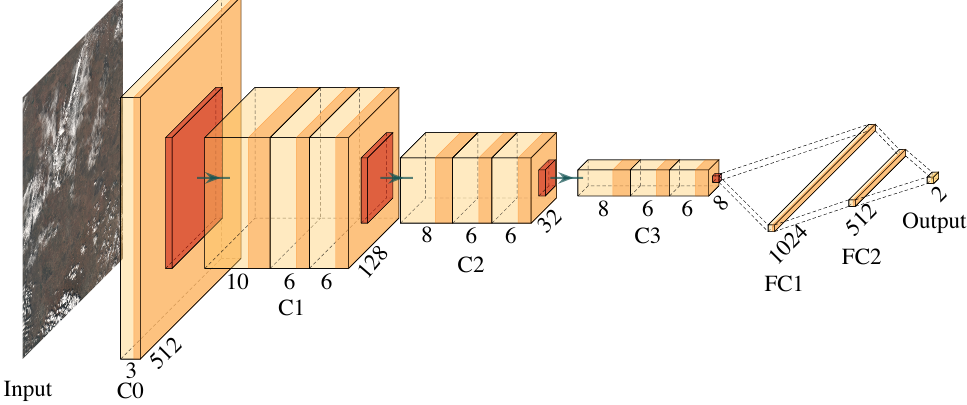
Figure 7. CloudSatNet-1